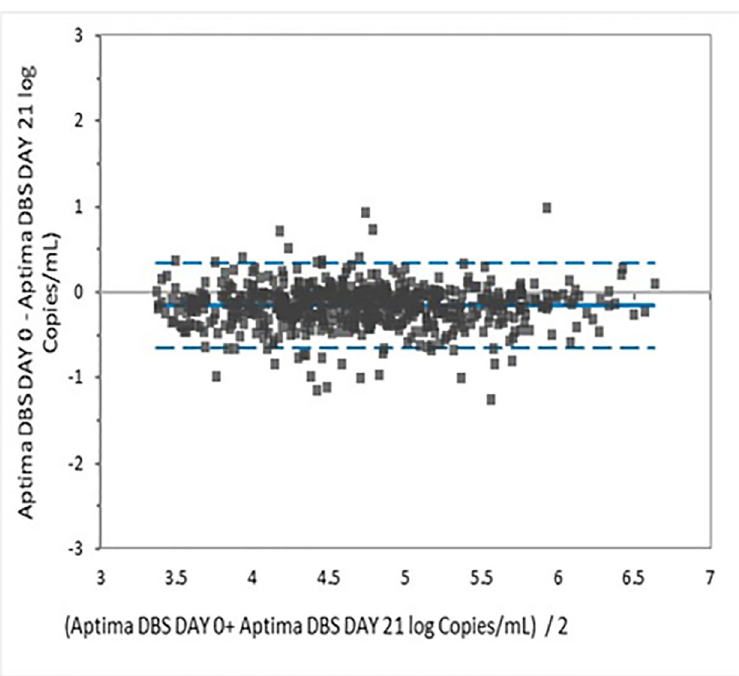
Fig 6. Bland Altman analysis of HIV VL in DBS tested on day 0 and day 21 in the Aptima assay.